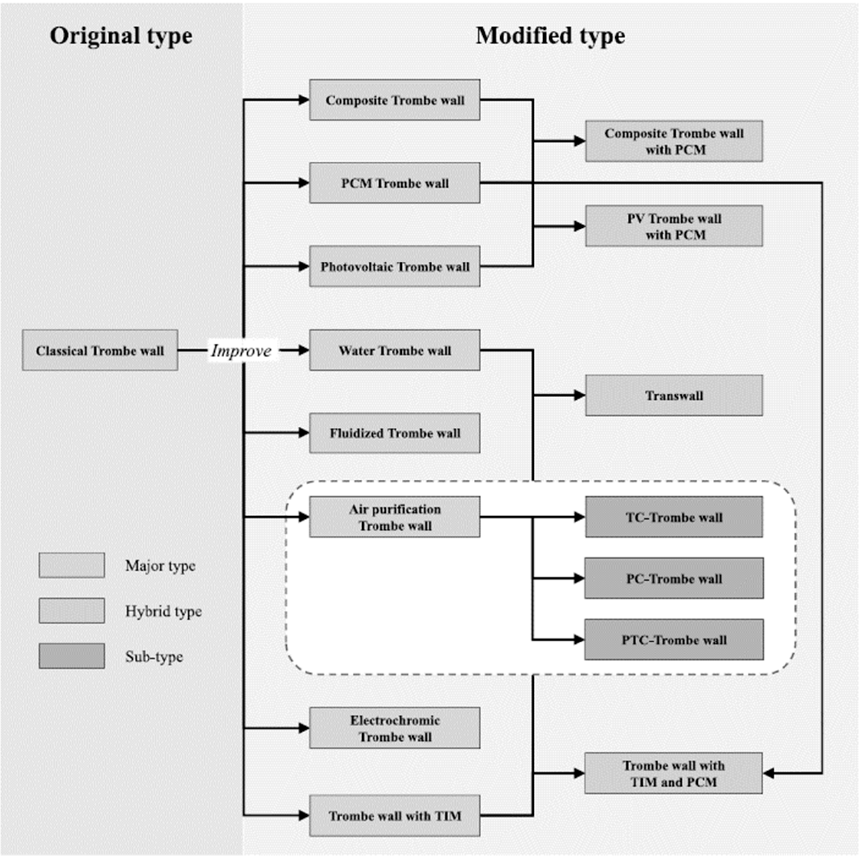
Figure 2. Various types and modifications of Trombe wall technology [3] .